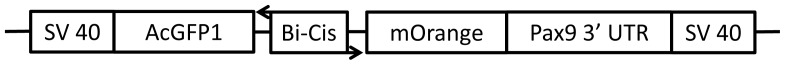
Diagram of reporter construct design.SV 40 = Simian virus 40 polyadenylation signal, AcGFP1 = green fluorescent protein, Bi-Cis = bicistronic promoter, mOrange = orange fluorescent protein, Pax9 3′ UTR = 3′ sequences of PAX9 from bat species described in the text. Experimental constructs differed only in the species from which PAX9 sequence was amplified. The control construct did not include a PAX9 3′ sequence.